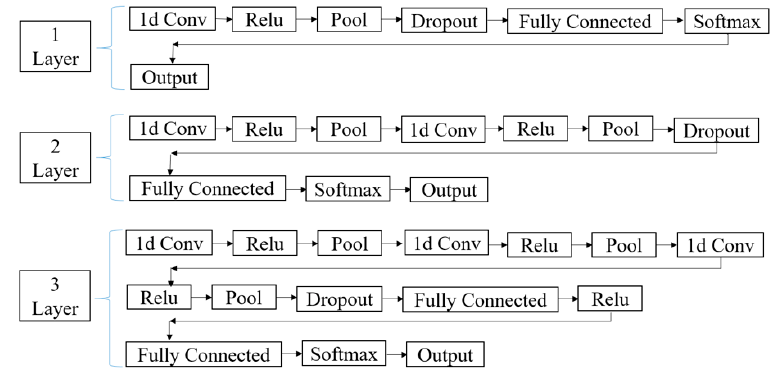
Figure 8. Architecture of a convolutional neural network (CNN) with 1–3 layers. Table 5. CNN with hyperparameter optimization (HPO): Range setting and optimized parameters.